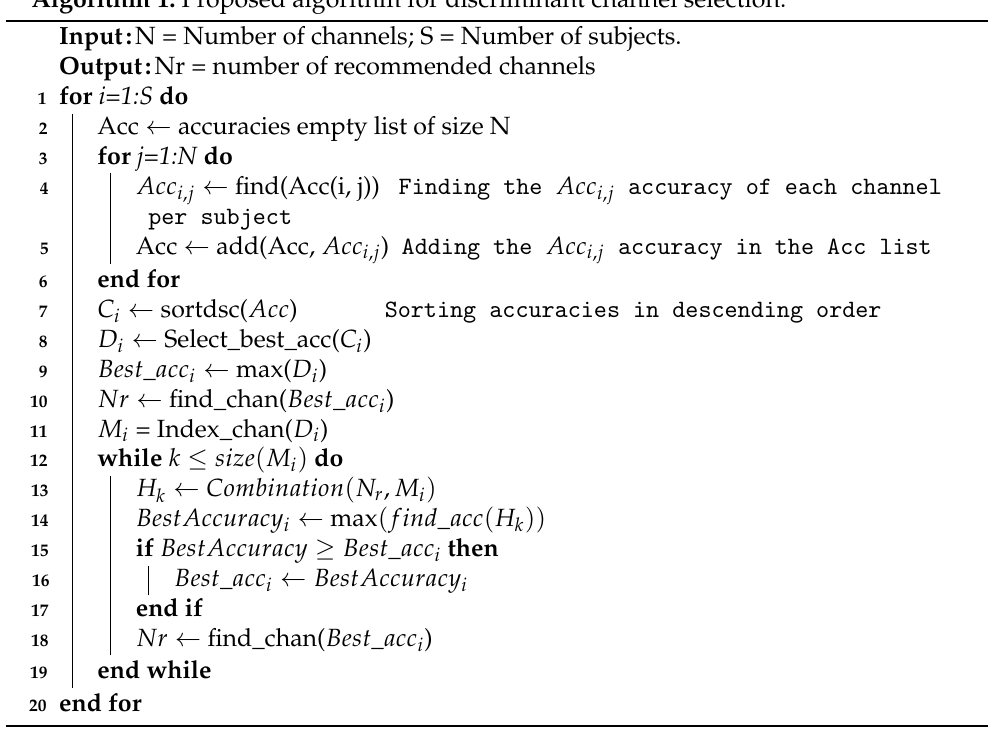
Algorithm 1: Proposed algorithm for discriminant channel